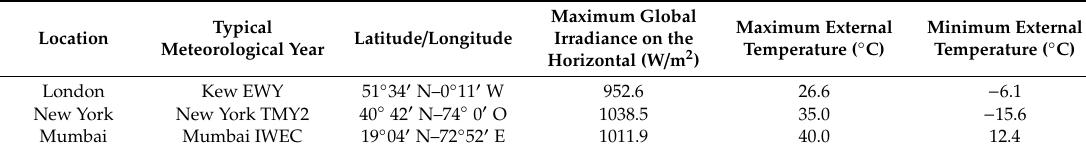
Table 3. General environmental data for the three cities under